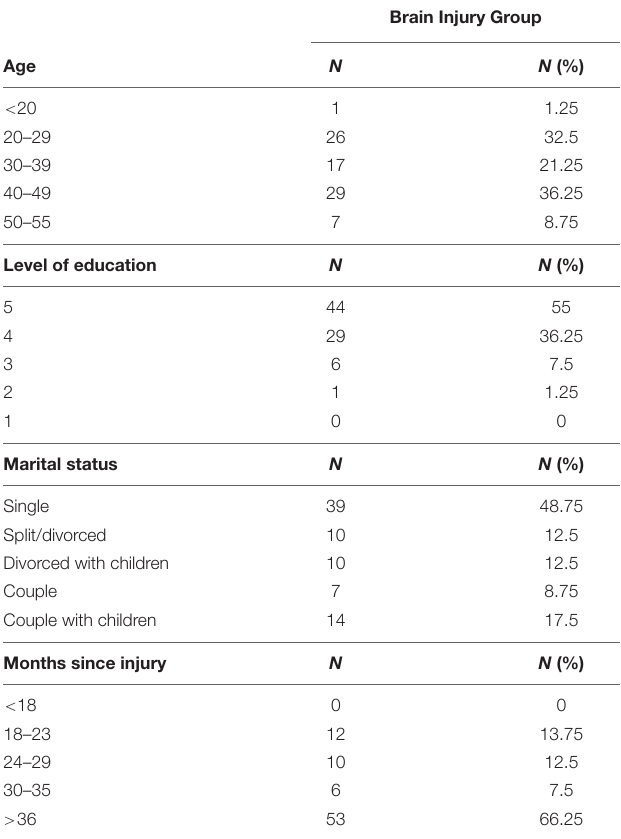
TABLE 1 | Descriptive characteristics of the Brain Injury Group (from 5 for primary education to 1 doctoral